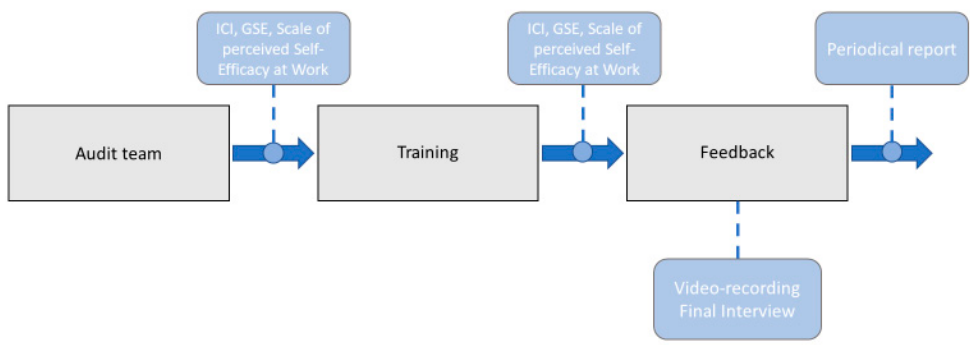
Figure 1. Structure of the